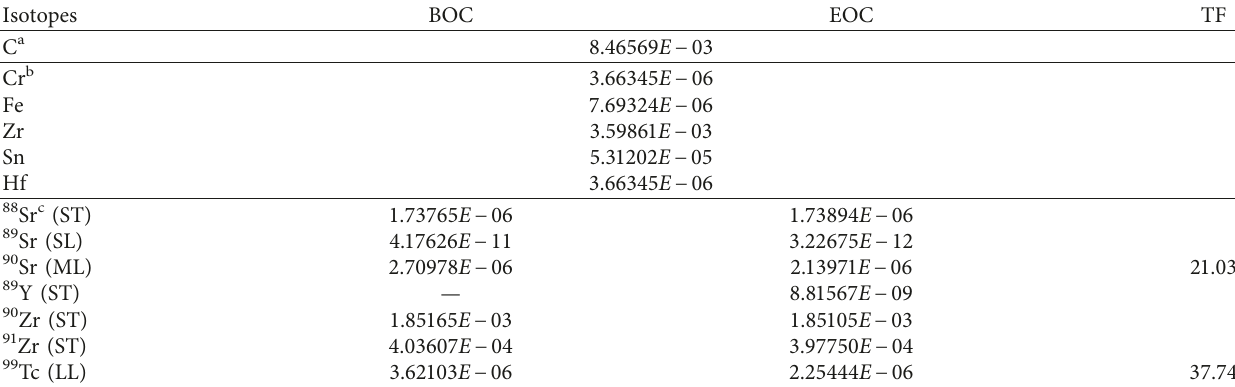
Table 2: Atomic densities of fission products in the spent fuel case of A (atoms/(barn · cm)) and transmutation fractions (%). Isotopes